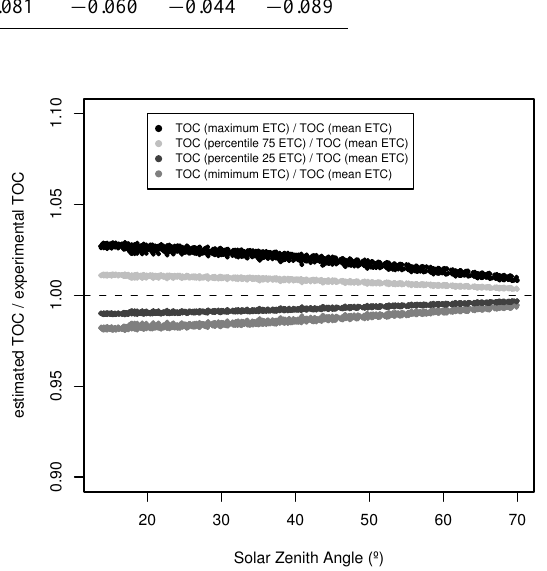
Fig. 2. The ratio of the estimated and the experimental total ozone column as a function of the solar zenith angle for the 30 se- lected cloud-free half-days (morning period). The experimental to- tal ozone data have been derived using the mean ETC value, and the estimated data using the maximum, minimum, percentile 75 and percentile 25ETC